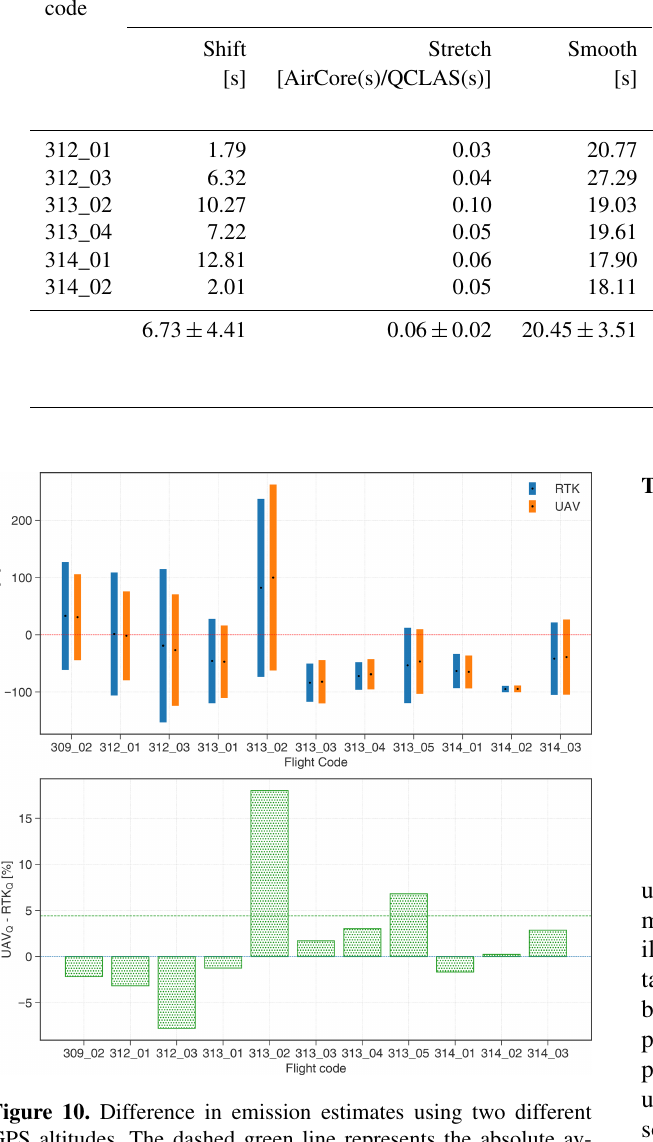
Table 3. Correction parameters and calculated emission rates for AirCore measurements. Flight